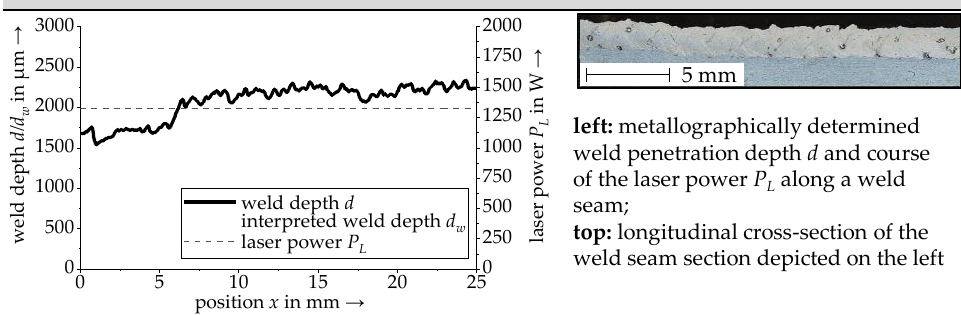
Figure 9. Comparison of the weld depth profiles for a targeted depth of 1.8 mm with a 300 µm deep notch for the aluminum alloy AA2219 with active weld depth control (top), for the aluminum alloy EN AW-6082 with active weld depth control and for the aluminum alloy EN AW-6082 without weld depth control.